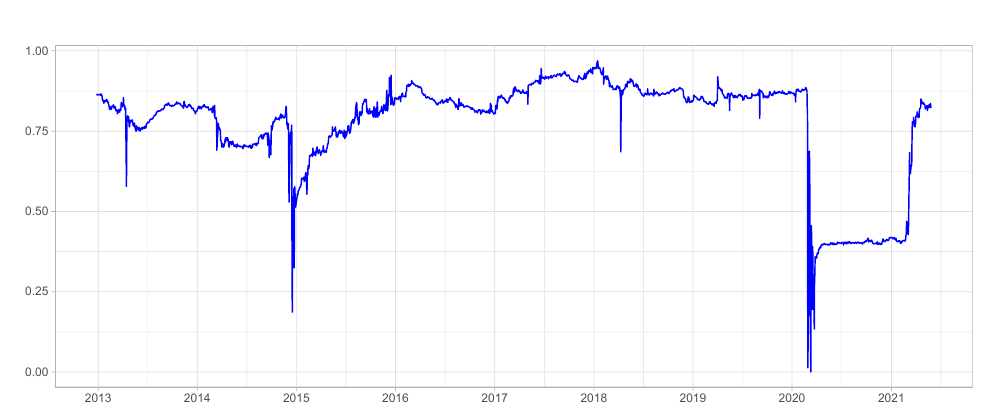
Figure A1. Dynamic MSE VAR / MSE DY